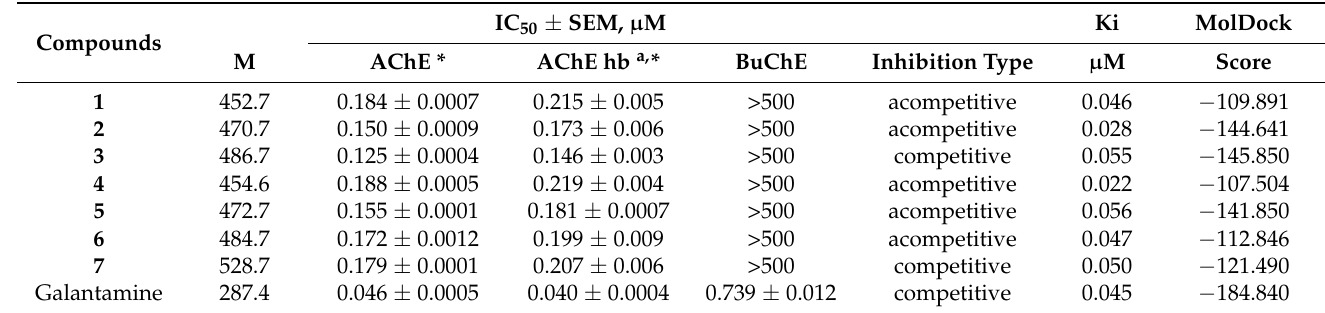
Table 1. Inhibition of acetylcholinesterase (AChE from Electrophorus electricus, and human blood) and butyrylcholinesterase (BChE from equine serum) from Ellman’s assays, IC 50 , Ki, Moldock value, and inhibition type for ceanothanes 1 – 7 used in this study.